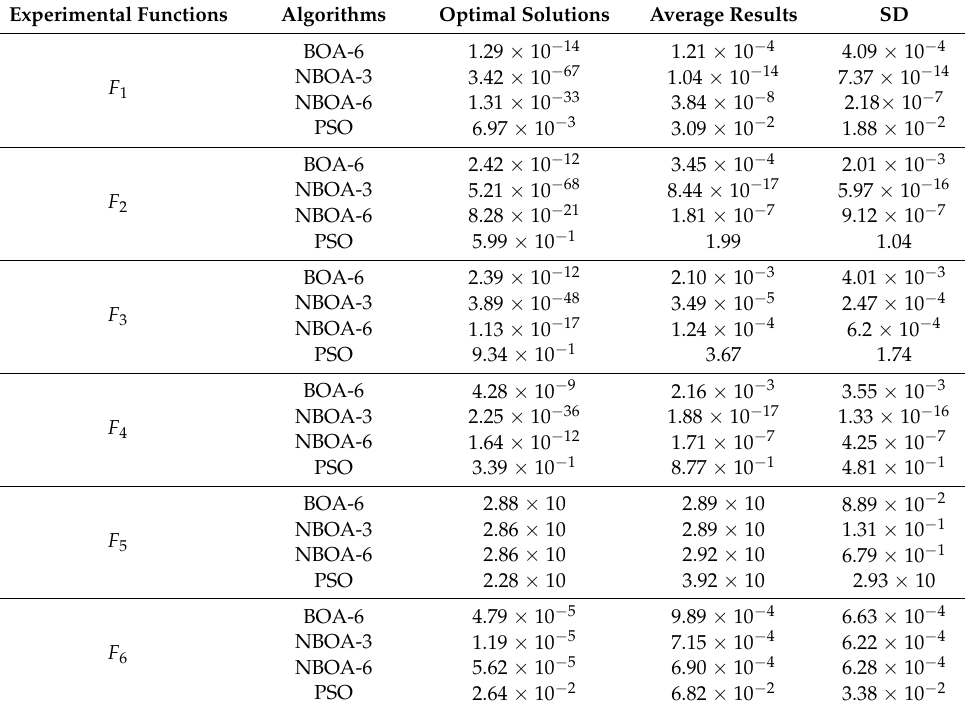
Table 7. Experimental results of unimodal function optimization.